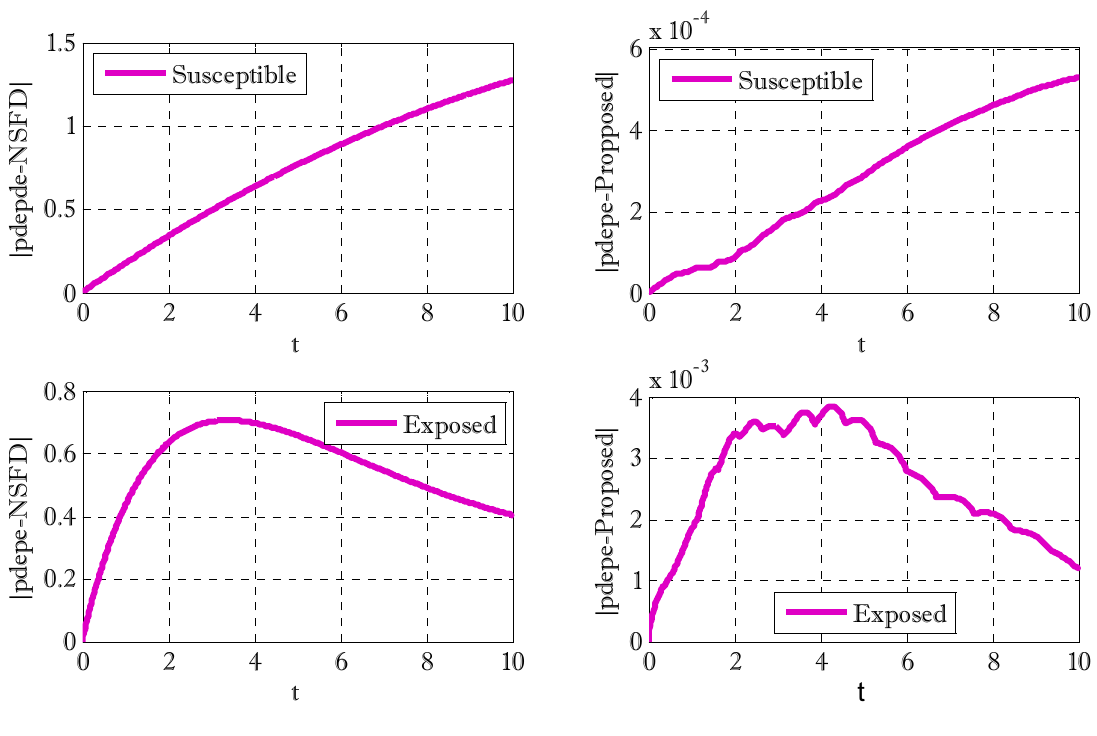
Figure 1. Two-dimensional comparison of proposed and NSFD schemes for susceptible and exposed individuals using L = 10, N x = 50, N t = 700, α 1 = 0.5, β = 0.3, γ = 0.4, σ = 0.1, µ = 0.1, d 1 = d 2 = d 3 = d 4 = d 5 = 0.9, α = 1.